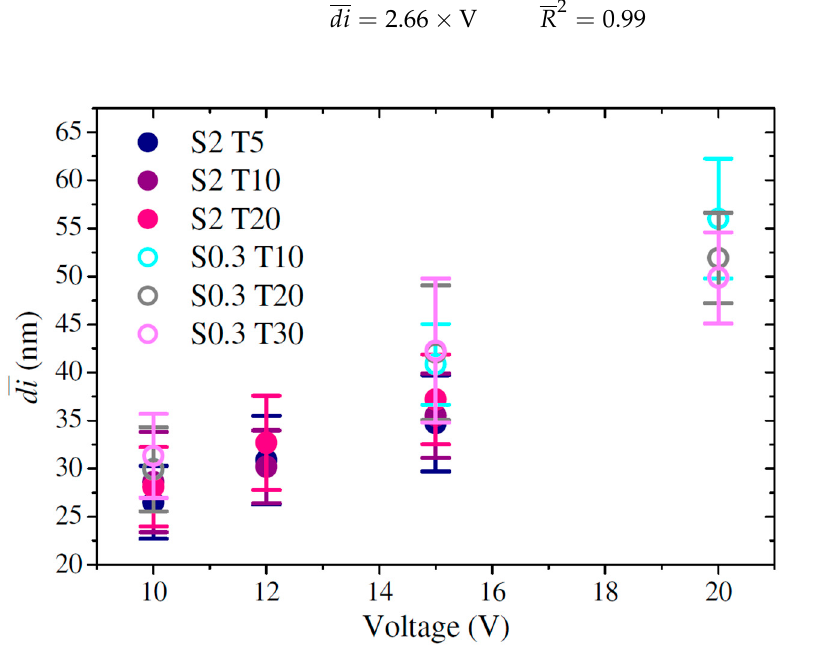
Figure 4. Variation of the average interpore distance of nanostructured aluminium oxide films anodized in sulphuric acid as a function of the concentration and temperature of the electrolyte and the voltage.